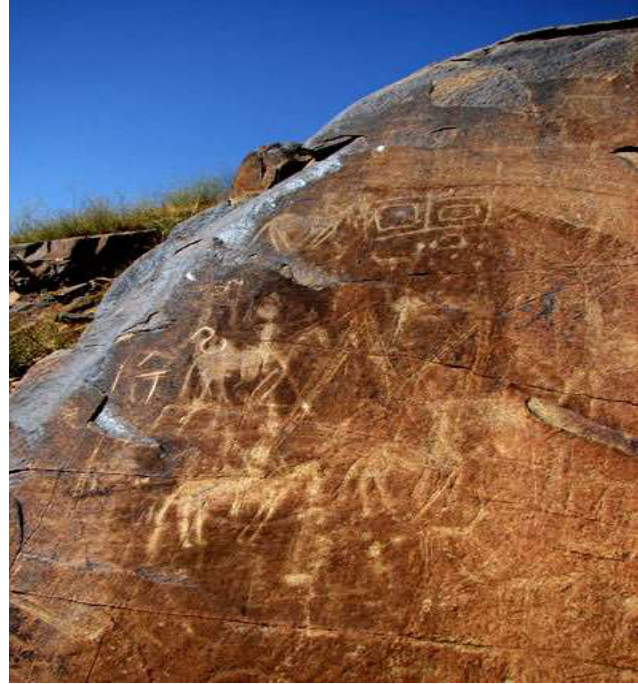
Figure 8. Saral, Kouchekcharmeg village, Sha Jou Mountain, “horse riders” “hunting”.